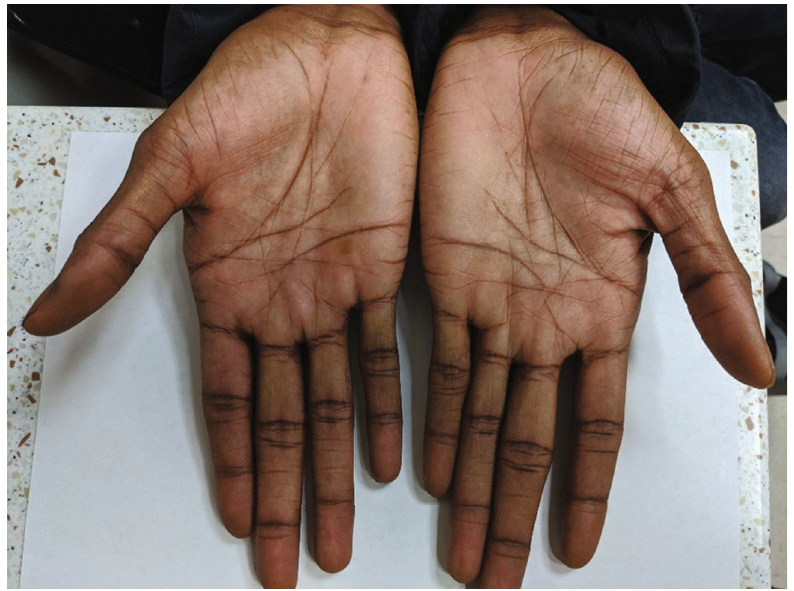
Figure 5: At 3 months follow-up, full range of motion of thumb